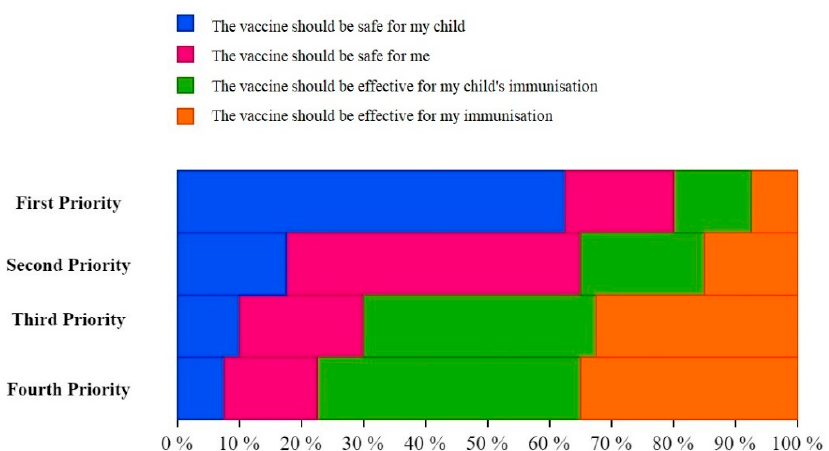
Figure 5. Top priorities of pregnant and lactating women (PLW) regarding COVID-19 vaccines, University Hospital Brno, August–October 2021 ( n = 362).